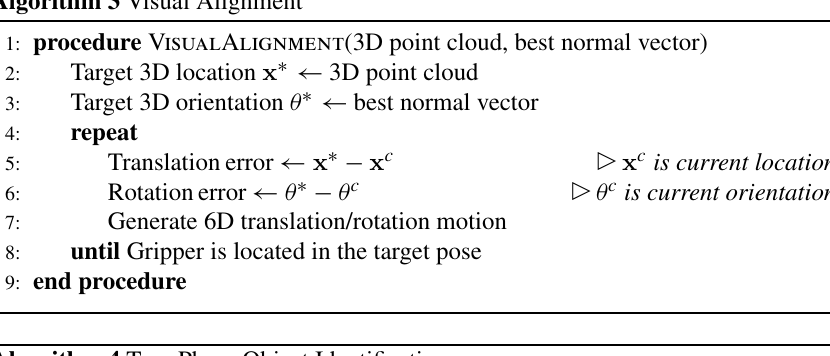
Algorithm 4 Two-Phase Object